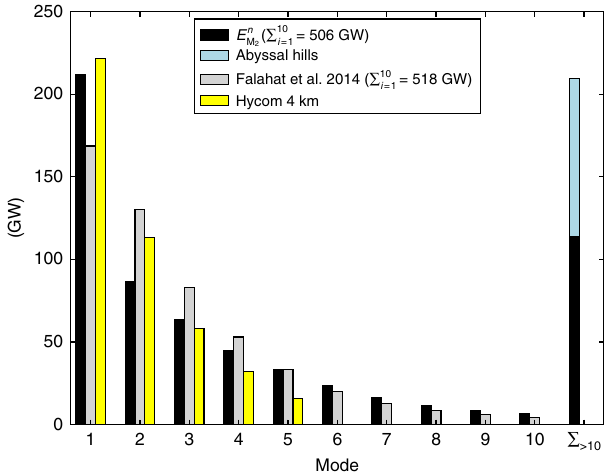
Fig. 3 Histogram of energy conversion as function of mode number. Global energy conversion below 700 m into the fi rst 10 modes, and for the sum of modes higher than 10 (rightmost bar), based on (black bars) our model complemented with (blue bar) the contribution of abyssal hills of Melet et al. 25 , (grey bars) Falahat et al. 23,60 , and (yellow bars) a global HYCOM simulation. Modes >10 were not computed in Falahat et al. 23 , and the HYCOM simulation does not resolve modes